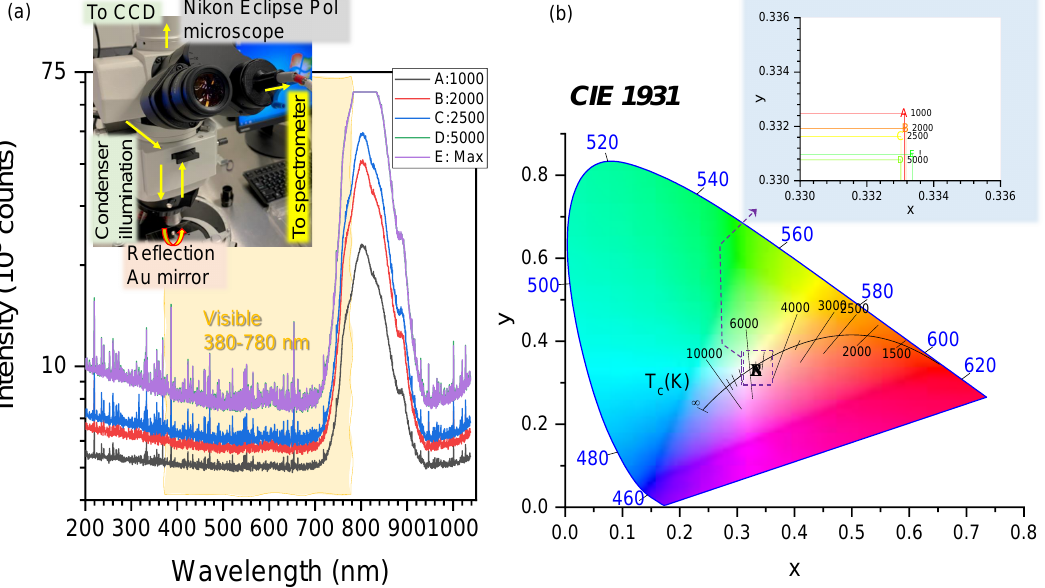
Figure A1. Chromaticity plot of a white light condensor (Xe-lamp) illumination upon reflection from a Au-mirror; note logarithmic intensity scale. Saturation occurred at 64 × 10 3 counts. ( a ) Spectra at different intensity settings. Inset: photo of the microscope. ( b ) Chromaticity xy-coordinates and zoom-in region in the inset for spectra shown in ( a ). Color temperature T c [K] is overlayed over the CIE 1931 chromaticity